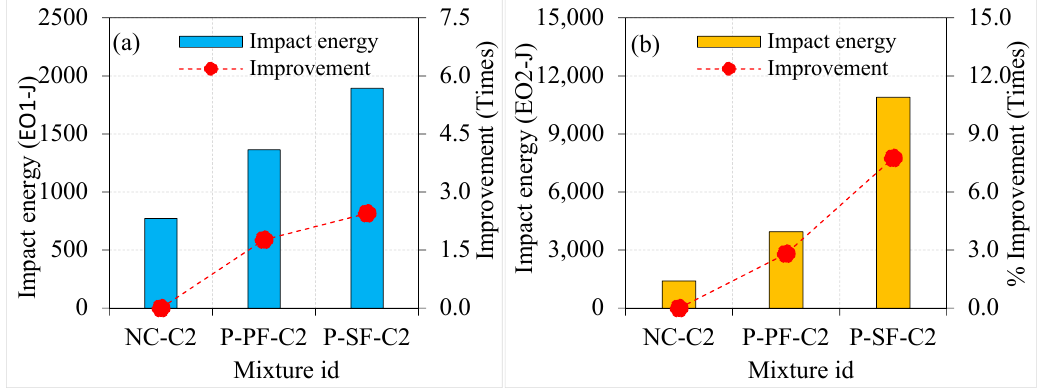
Figure 15. Effect of fibres on double-coated aggregate specimens ( a ) EO1 and ( b ) EO2. The impact energies corresponding to cracking and failure showed prominent en- hancements, for the single and double asphalt-coated aggregate specimens as displayed in Figures 14 and 15. Compared to NC-C1, the EO1 and EO2 values were 1.85 and 2.91 times higher for the P-PF-C1 specimens. Likewise, these values were higher by 2.65 and